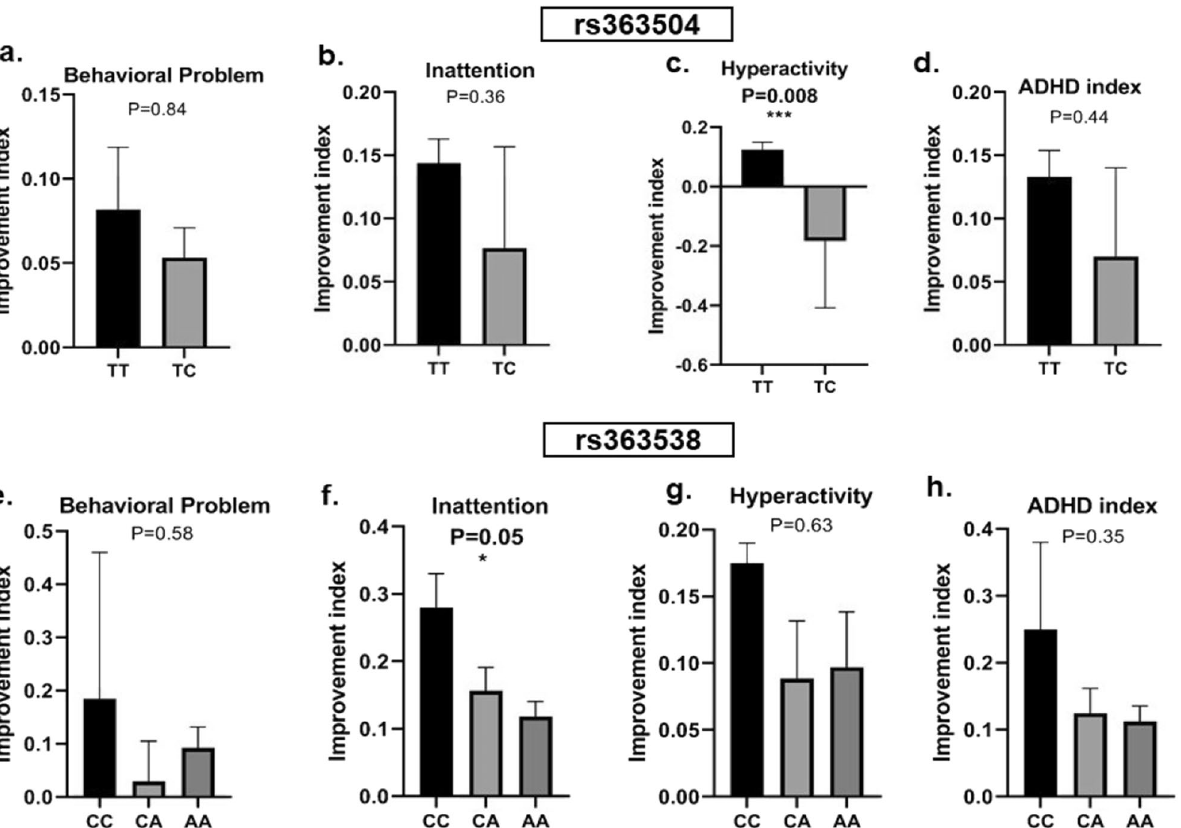
Figure 1. Association between GRIK1 genetic variants and methylphenidate-induced changes in the trait scores, measured based on the improvement index, was analyzed by the Unpaired t-test using the Prism 9.0 software; ( a , e ) Behavioral problem; ( b , f ) Inattention; ( c , g ) Hyperactivity; ( d , h ) ADHD index. Statistically, significant differences are presented in bold (*).